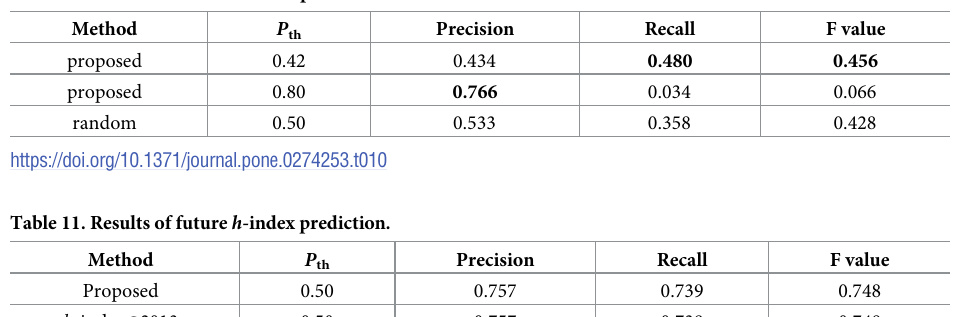
Table 10. Results of future citation prediction.